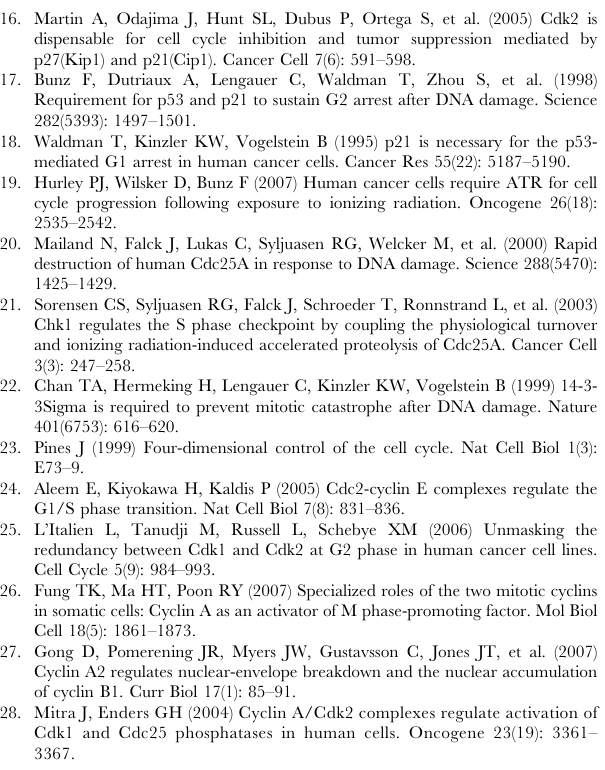
Figure S3 Interaction of Cdc6 with ATR and modulation of Chk1-Cdc25A signaling. (A) Levels of Cdc6 were determined